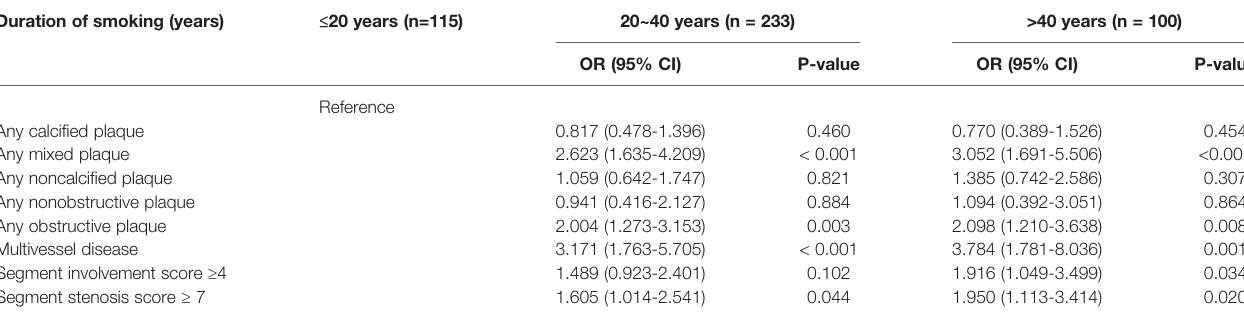
TABLE 4 | Multivariate regression analysis of the association of coronary artery plaques in diabetes with smoking duration. Duration of smoking (years)